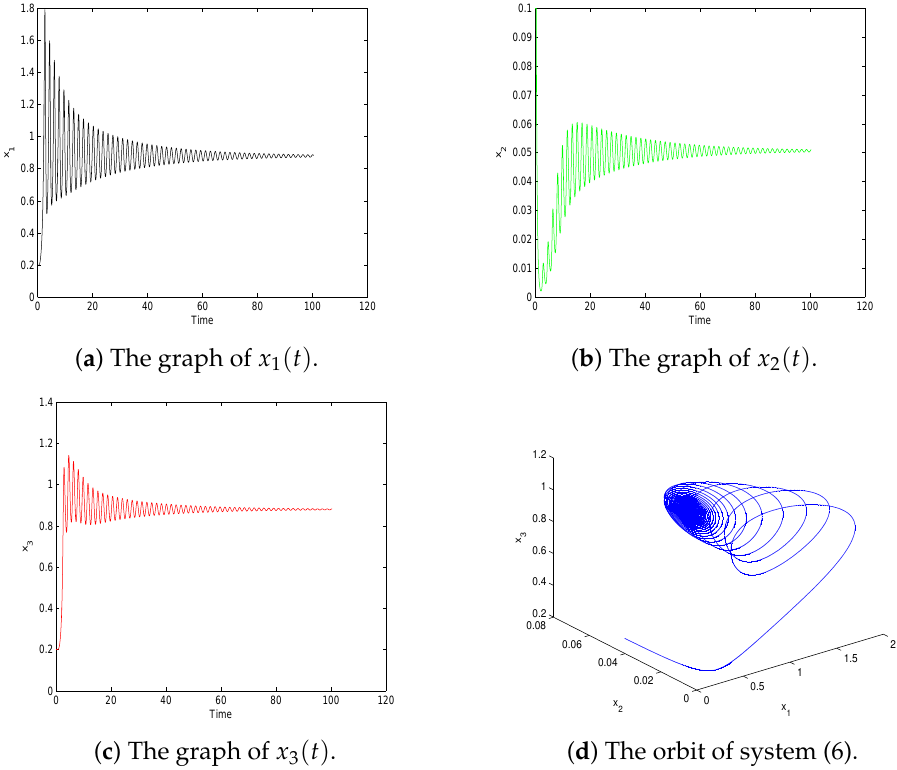
( d ) The orbit of system (6).